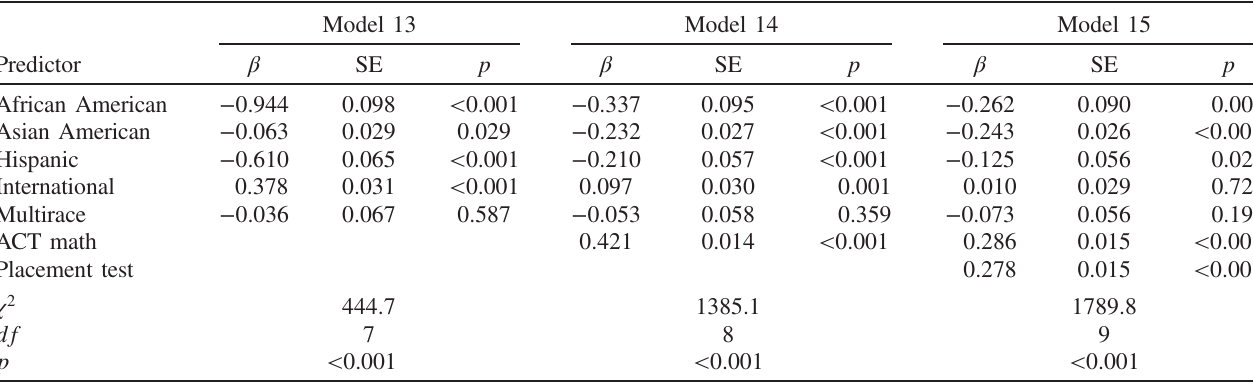
TABLE XII. Differentiated models predicting physics 1 final exam scores, fall data. a